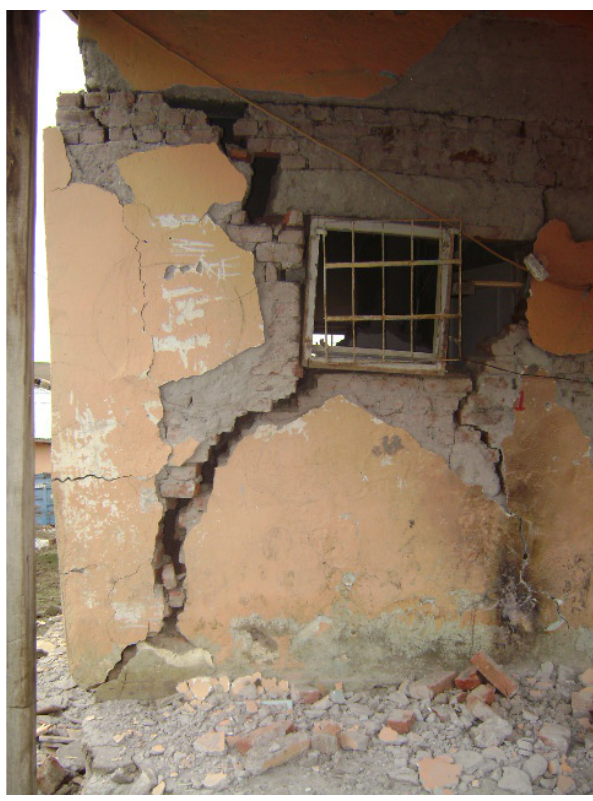
Fig. 9. Wall opening close to the building corner.